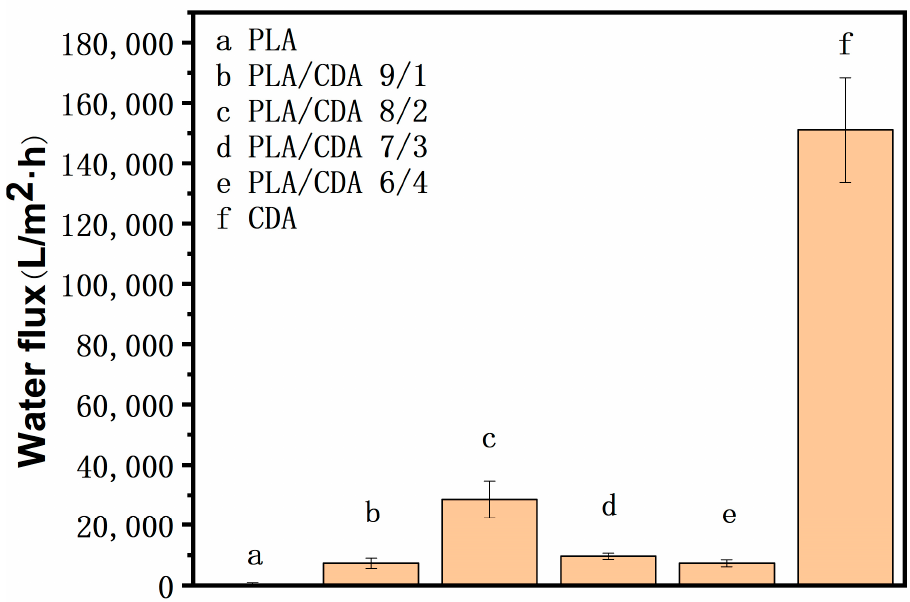
Figure 9. Water flux maps of different polymers: ( a ) PLA, ( b ) PLA/CDA (9/1), ( c ) PLA/CDA (8/2), Figure 9. Water fl ux maps of di ff erent polymers: ( a ) PLA, ( b ) PLA/CDA (9/1), ( c ) PLA/CDA (8/2), ( d ) PLA/CDA (7/3), ( e ) PLA/CDA (6/4), ( f ) ( d ) PLA/CDA (7/3), ( e ) PLA/CDA (6/4), ( f ) CDA.